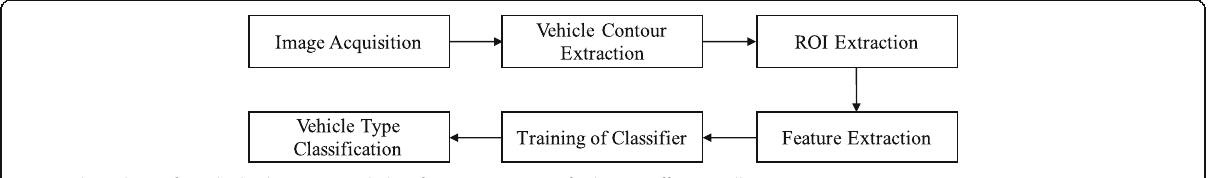
Fig. 1 Flow chart of a vehicle detection and classification system to facilitate traffic surveillance